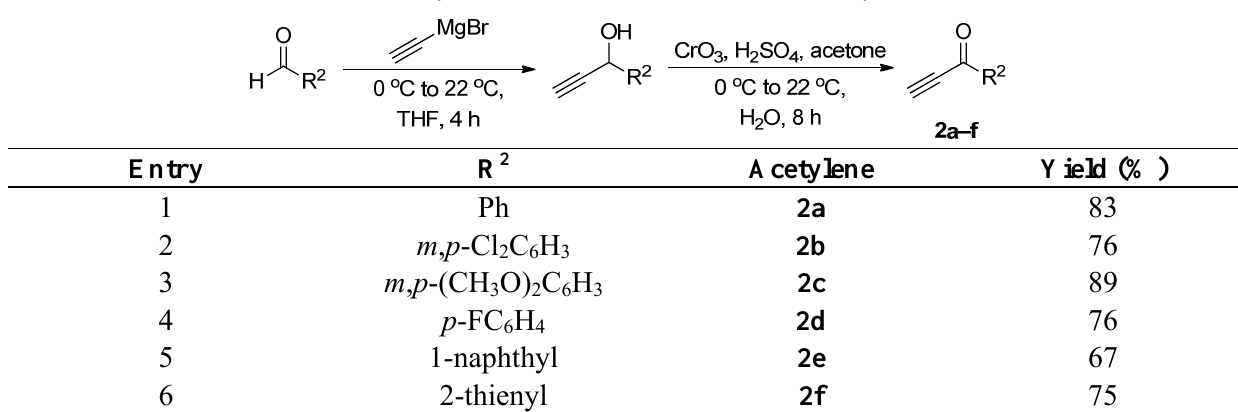
Table 1. Synthesis of Electron-Deficient